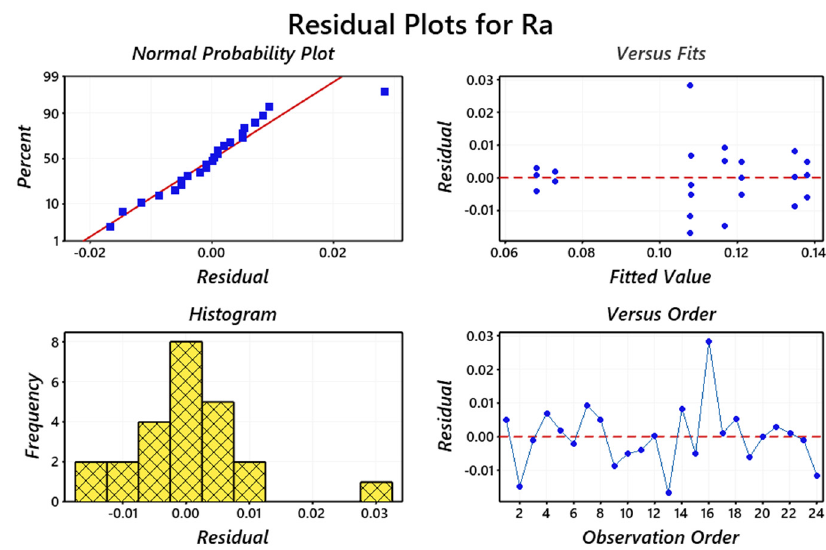
Figure 2. Residual plots of surface roughness R a.